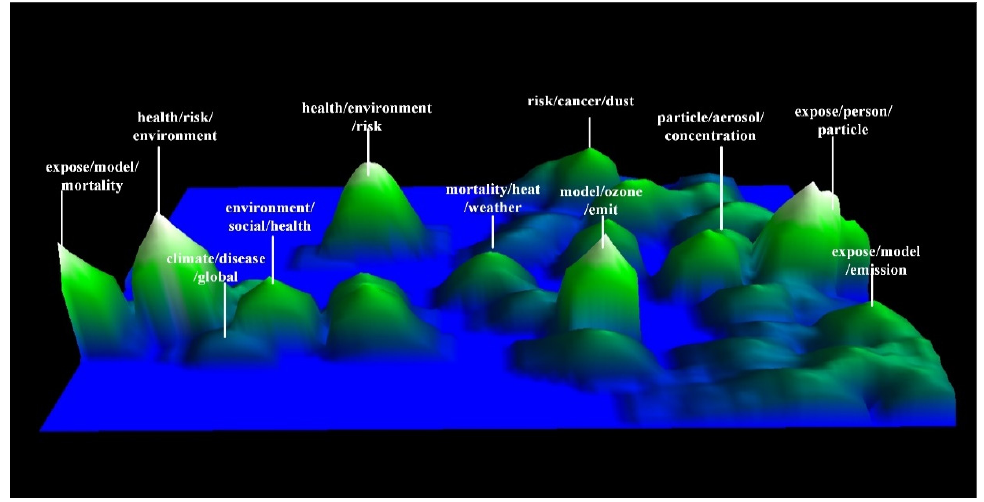
Figure 6. Theme map of keywords .